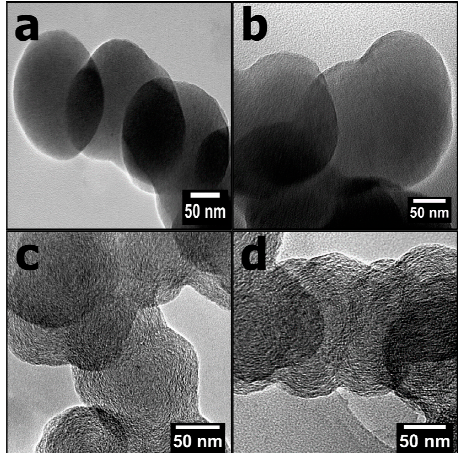
Figure 1. High magnification TEM images of ( a ) CSs, ( b ) BN-CSs, ( c ) activated CSs and ( d ) activated BN-CSs.